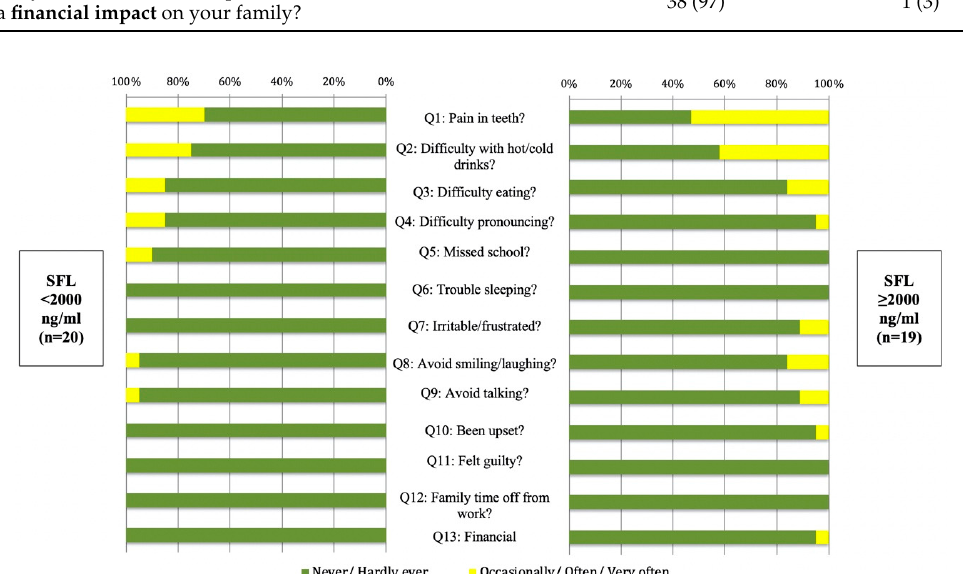
Figure 1. Stacked bar-chart showing the response percentages of the β -thalassemia major (BTM) participants with serum ferritin level (SFL) < 2000 ng / mL (n = 20) and with SFL ≥ 2000 ng / mL (n = 19) to all 13 questions of the Early Childhood Oral Health Impact Scale (ECOHIS). No significant di ff erences between the groups were detected using the chi-square test ( p >